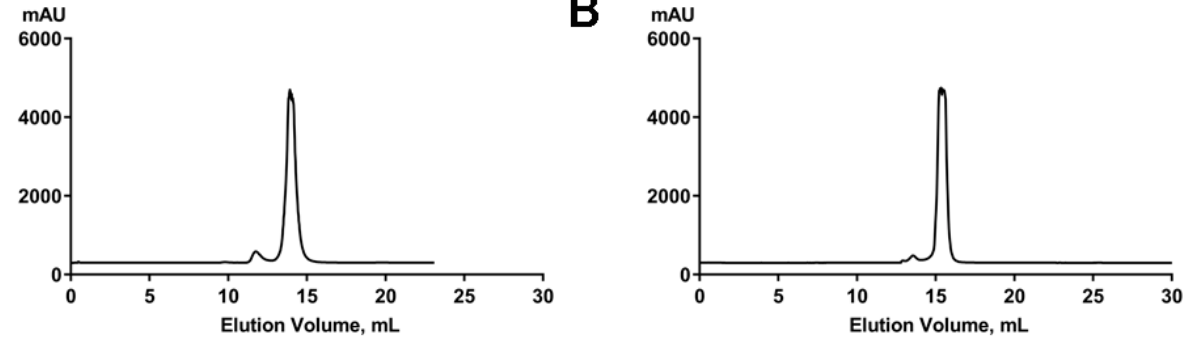
Figure 3. Analysis of the homogeneity and conformation of the THF-II RNA. ( A ) SEC elution profile of the THF-II riboswitch in the absence of the ligand. RNA concentration: 10 mg/mL. ( B ) SEC elution profile of the THF-II riboswitch in the presence of the ligand. RNA concentration: 10 mg/mL. Vertical axes for ( A , B ) are in mAU at 254 nm.